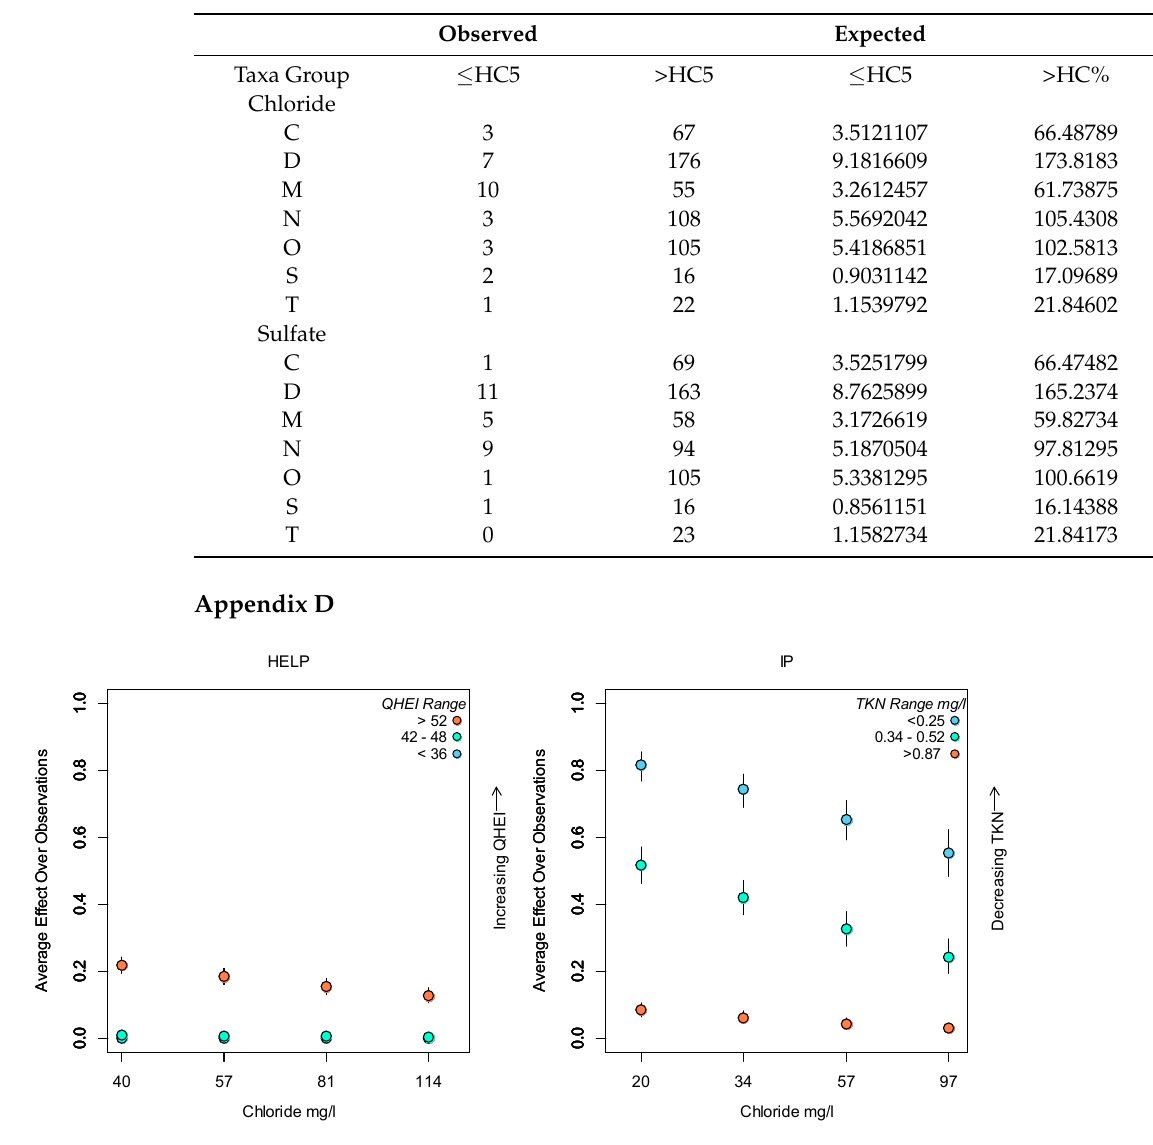
Figure A1. Probabilities of observing macroinvertebrate communities meeting the ecoregion benchmarks for the Huron-Erie Lake Plain (HELP, left panel) and the Interior Plateau (IP, right panel) given four levels of chloride and observations of covariates within three data slices defined by quantile levels of the QHEI for the HELP and TKN for the IP (lower, middle and upper 25th quantiles). The respective chloride levels were obtained by sequencing the ecoregion range from the 25th to 90th percentiles (in log space). The results for the HELP illustrate the dramatic influence of poor habitat quality. The results for the IP, suggest that ecoregion is particularly susceptible to negative effects from organic and nutrient en- richment.